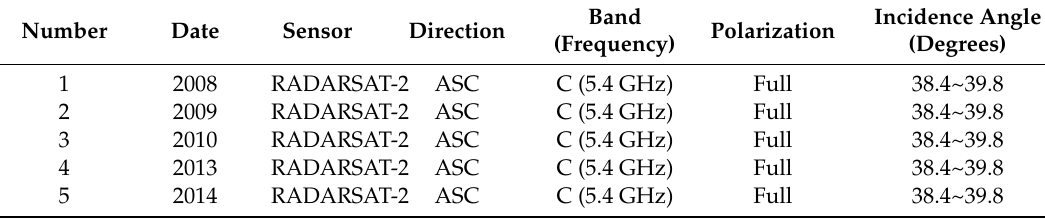
Figure 10. Pauli RGB images of the third group of time-series images, with red | S HH − S VV | 2 , green 4 | S HV | 2 , and blue | S HH + S VV | 2 . The image of 2008 is the source domain and the other images are the target domain. Table 4. Description of the third group of time-series images.